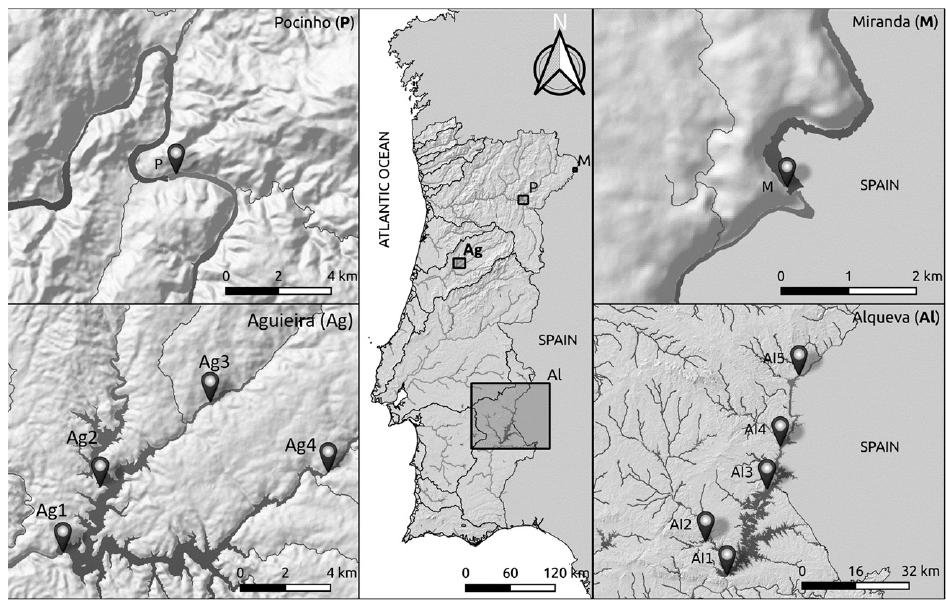
Figure 1. Location of the sampling sites in Miranda (M—41°29 ′ 24.802 ″ N, 6°15 ′ 55.925 ′′ W), Pocinho (P—41°08 ′ 10.884 ″ N, 7°06 ′ 39.074 ″ W), Aguieira (Ag1—40°20 ′ 27.942 ″ N, 8°11 ′ 38.616 ″ W, Ag2— 40°22 ′ 01.884 ″ N, 8°10 ′ 28.283 ″ W, Ag3—40°24 ′ 03.488 ″ N, 8°07 ′ 01.150 ″ W and Ag4—40°22 ′ 22.256 ″ N, 8°03 ′ 19.055 ″ W) and Alqueva (Al1—38°12 ′ 07.957 ″ N, 7°29 ′ 19.717 ″ W, Al2—38°17 ′ 35.785 ″ N, 7°33 ′ 41.484 ″ W, Al3—38°25 ′ 58.085 ″ N, 7°21 ′ 03.721 ″ W Al4—38°32 ′ 49.092 ″ N, 7°18 ′ 13.988 ″ W and Al5—38°44 ′ 15.763 ″ N, 7°14 ′ 15.144 ″ W).